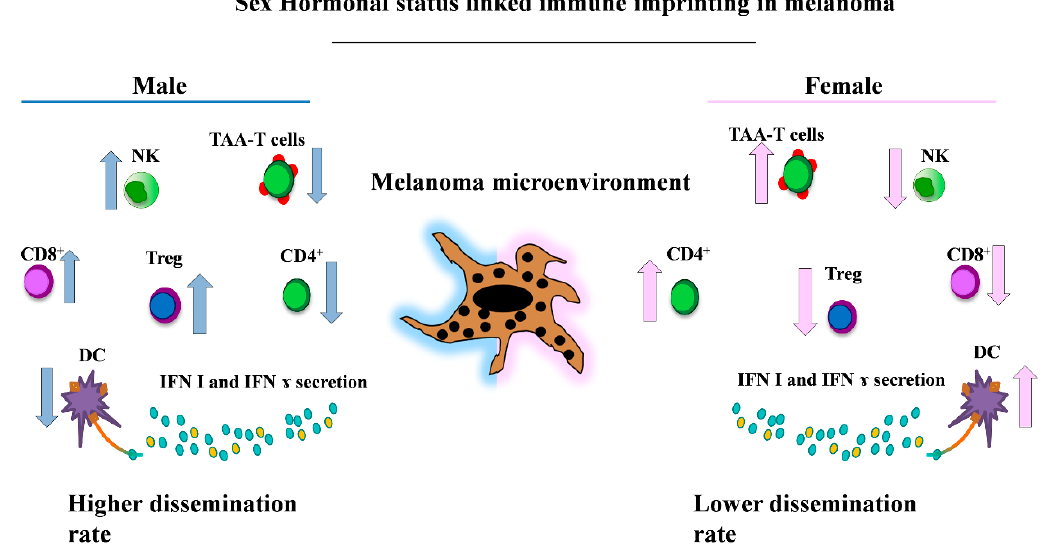
Figure 2. Key gender-related differences of the immune cell populations involved in melanoma. This representative picture shows the main immune cell populations present with higher frequencies in males (i.e., CD8 + , Treg and NK cells [12,123–125]) ( left ) and in female patients (i.e., the immune phenotype enriched in TAA-T cells, CD4 + and DCs cells [80,123,124,126] with higher levels of circulating Interferon I (IFN I) and IFN γ [80,84,85]) ( right ). NK: natural killer; TAA: tumor-associated antigen; DCs: dendritic cells.